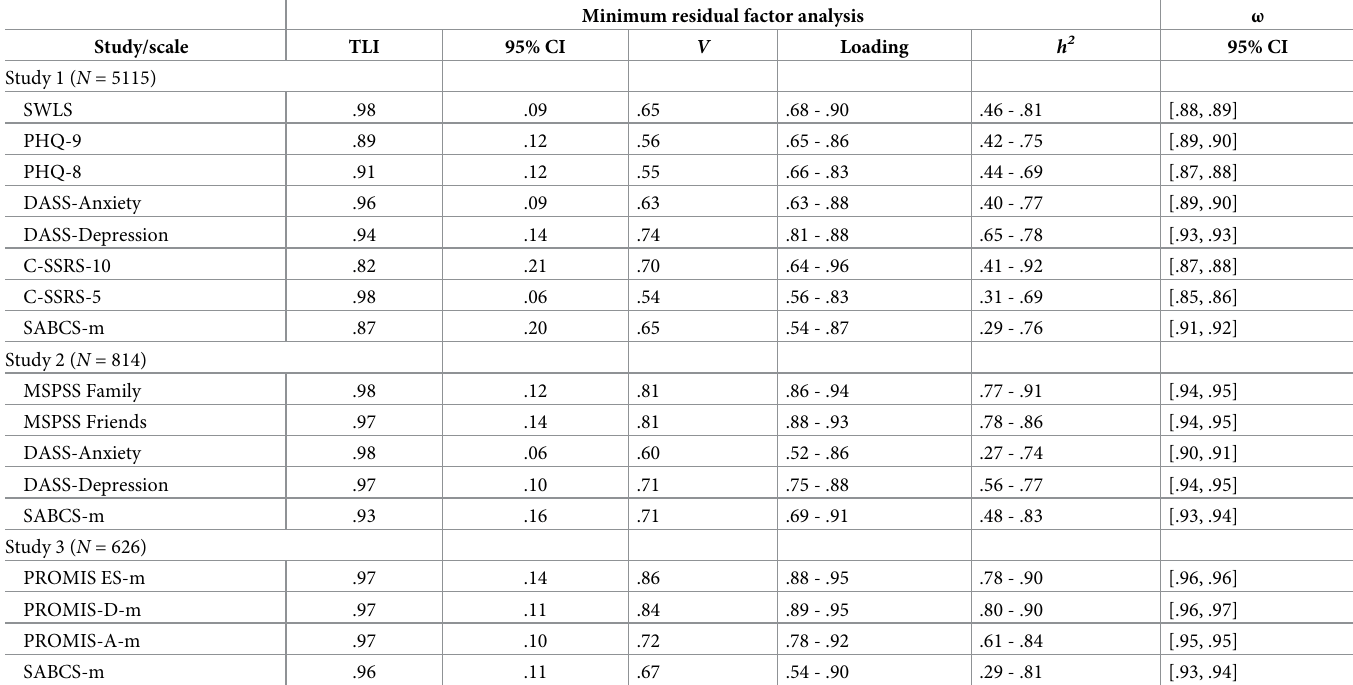
Table 1. Factor analyses and internal consistencies of study